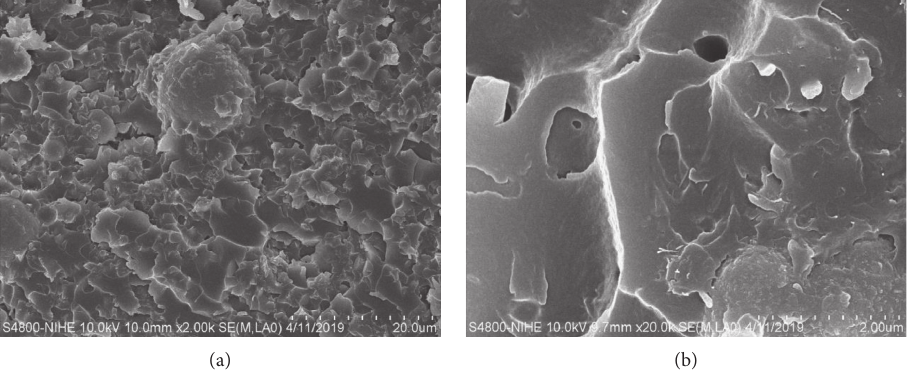
Figure 7: SEM images of nanocomposites fly ash/MWCNTs/epoxy: 40 wt.% fly ash/0.04